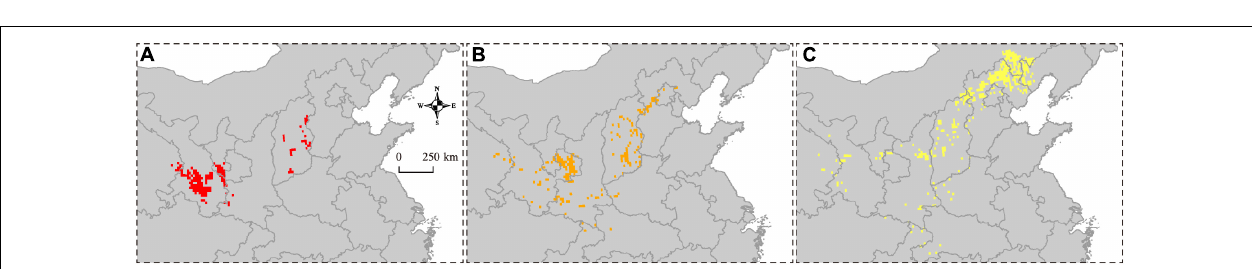
FIGURE 4 | Variations in the predicted areas of the past (1905–2000), current (2000–2016) and future (2050 and 2100 based on CSIRO-Mk3.0 global climate model with A1B and A2 scenarios) distributions.